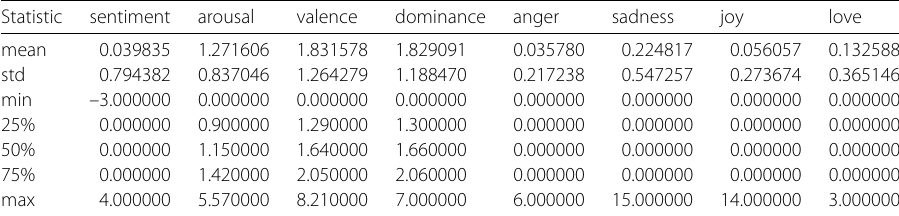
Table 3 Summary statistics of affect metrics for Ethereum. Mean, standard deviation, min-max values considering all Github comments for sentiment, arousal, valence, dominance, anger, joy, love